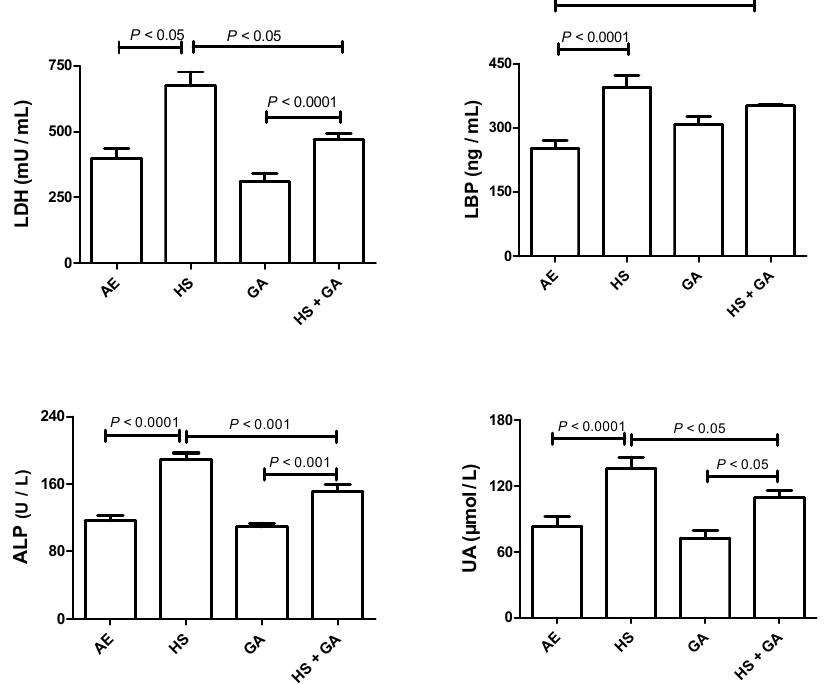
Figure 1. The plasma levels of lactate dehydrogenase (LDH), lipopolysaccharide-binding protein (LBP), alkaline phosphatase (ALP), and uric acid (UA) in mice exposed to normal air (AE), and hookah smoke (HS, 30 min / day) or treated with gum acacia (GA, 15% w / v ) with or without exposure to HS. Each vertical column with bar represents the mean ± SEM (from 8 mice in each group). The p < 0.05 was considered significant.